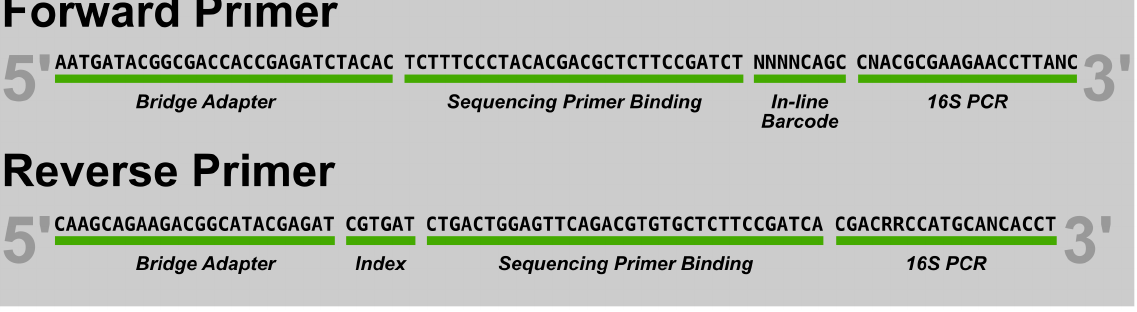
Figure 1. Structure of V6 fusion primers used to generate amplicon libraries for Illumina sequencing.